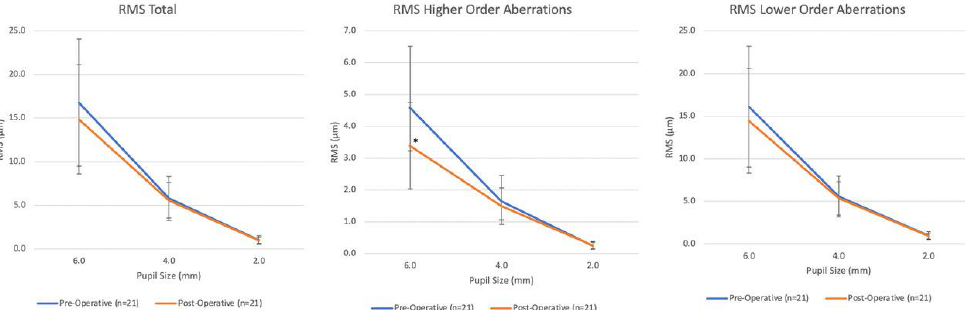
Figure 2. Pre- and post-operative absolute mean values in root mean square (RMS) higher- (HOA) and lower-order aberration (LOA) at 6 mm, 4 mm, and 2 mm pupil diameters. Comparison of pre- operative and post-operative measurements of total aberrations, higher order aberrations, and lower order aberrations at pupil sizes of 6.0 mm, 4.0 mm, and 2.0 mm. Error bars indicate standard deviation. * Results were found to be statistically significant p < 0.05. Statistical analysis was obtained using generalized least squares linear models comparing pre-operative and post-operative measurements at each pupil size.